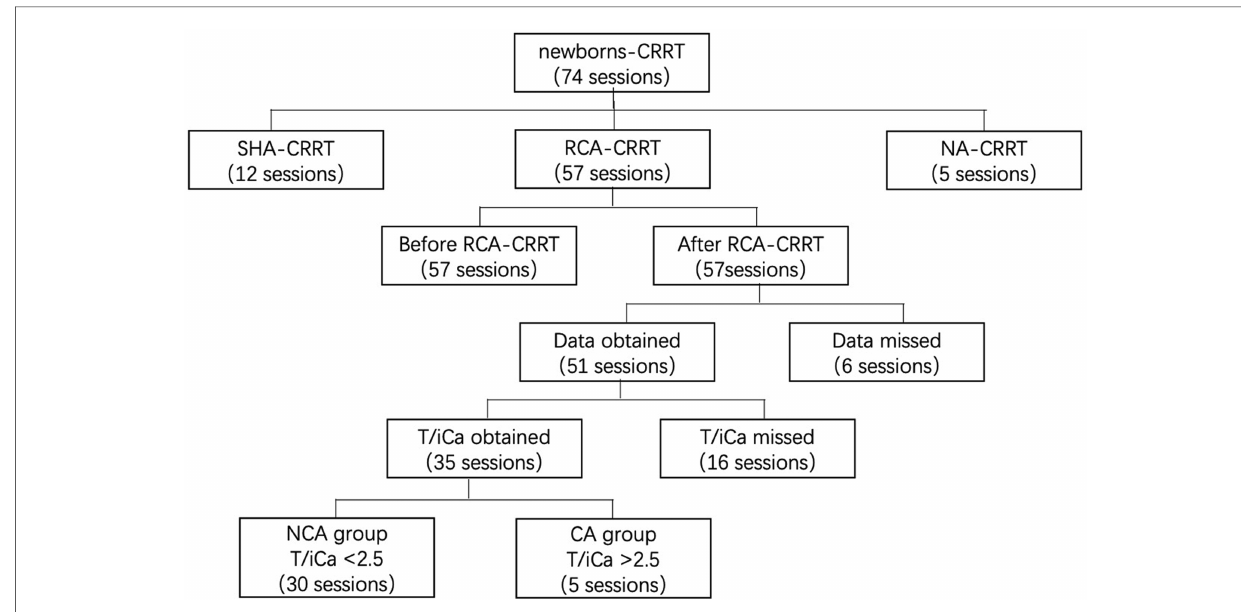
FIGURE 1 Data collection. CRRT, continuous renal replacement therapy; SHA, systemic heparin anticoagulation; NA, no anticoagulation; CA, citrate accumulation, T/iCa>2.5 at the end of RCA-CRRT; NCA, no citrate accumulation, T/iCa<2.5 at the end of RCA-CRRT; T/iCa, ratio of total calcium to ionic